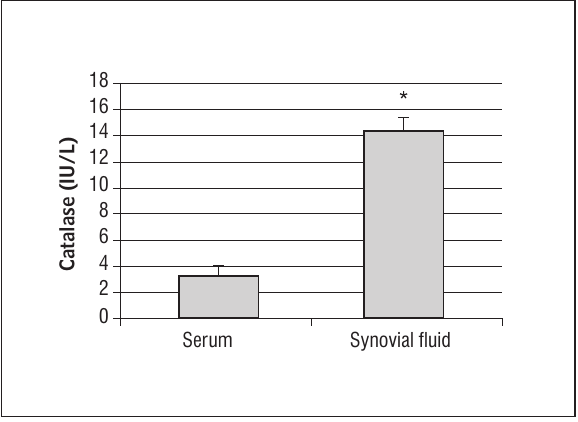
Figure 3 - Comparative analysis of catalase activity in serum and in